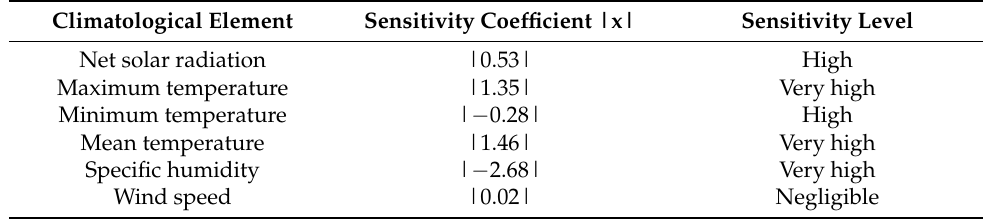
Table 3. Sensitivity coefficient of climatic factor for